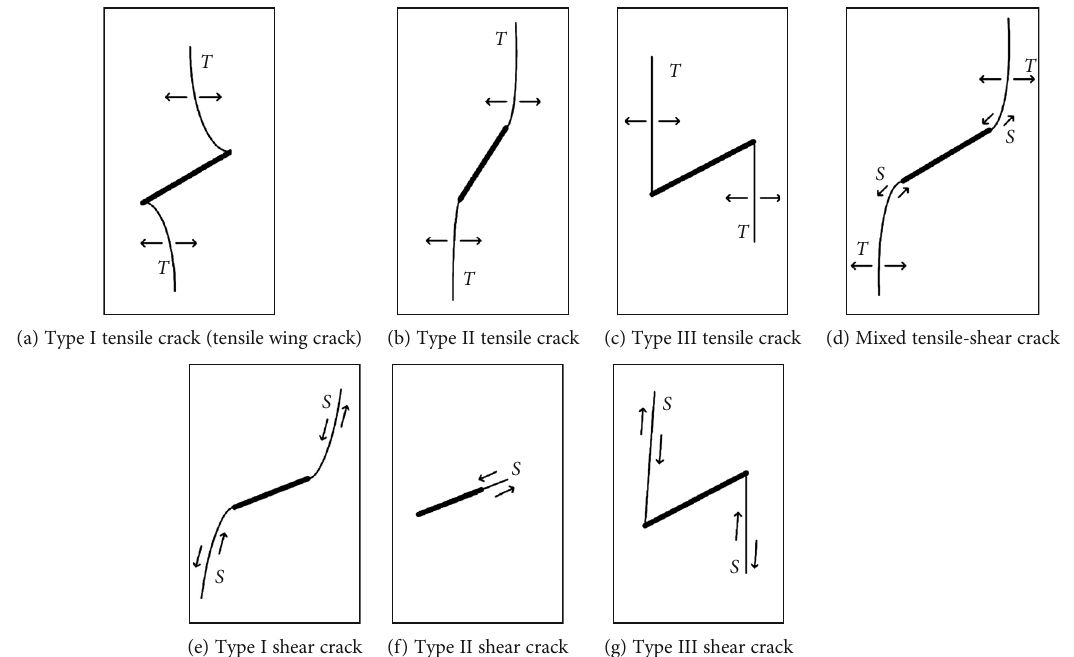
Figure 19: The tensile crack types initiated from the preexisting fl aws by Wong and Einstein [31]. T : tensile cracking opening; S : shearing